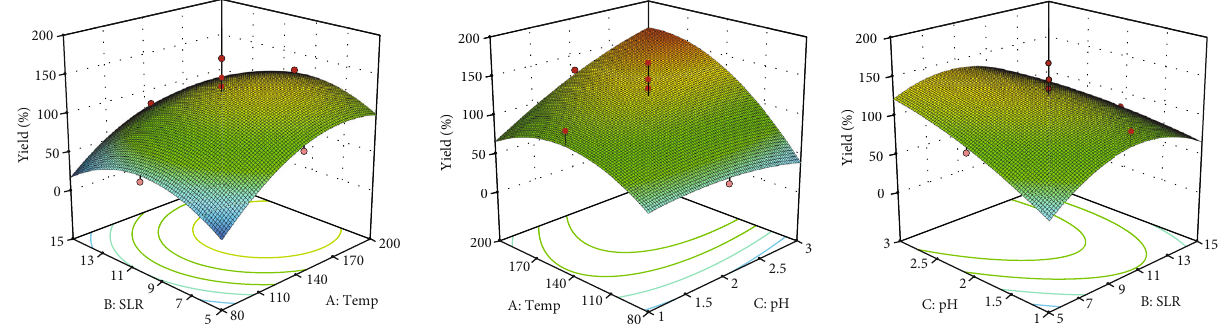
Figure 1: Response surface model for the microwave-assisted extraction of pectin from “ Saba ” banana peel waste.